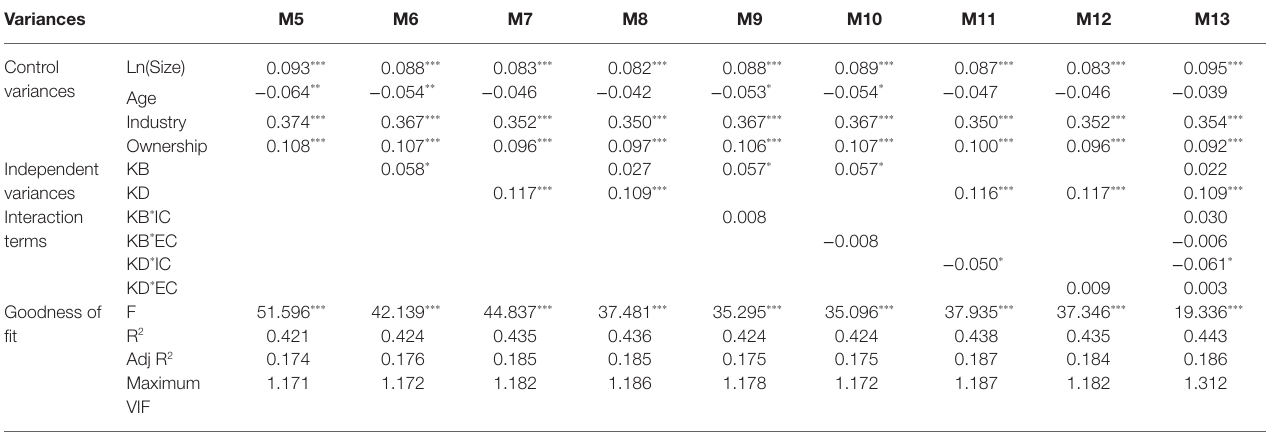
TABLE 4 | Hierarchical regression analysis results of technological innovation.